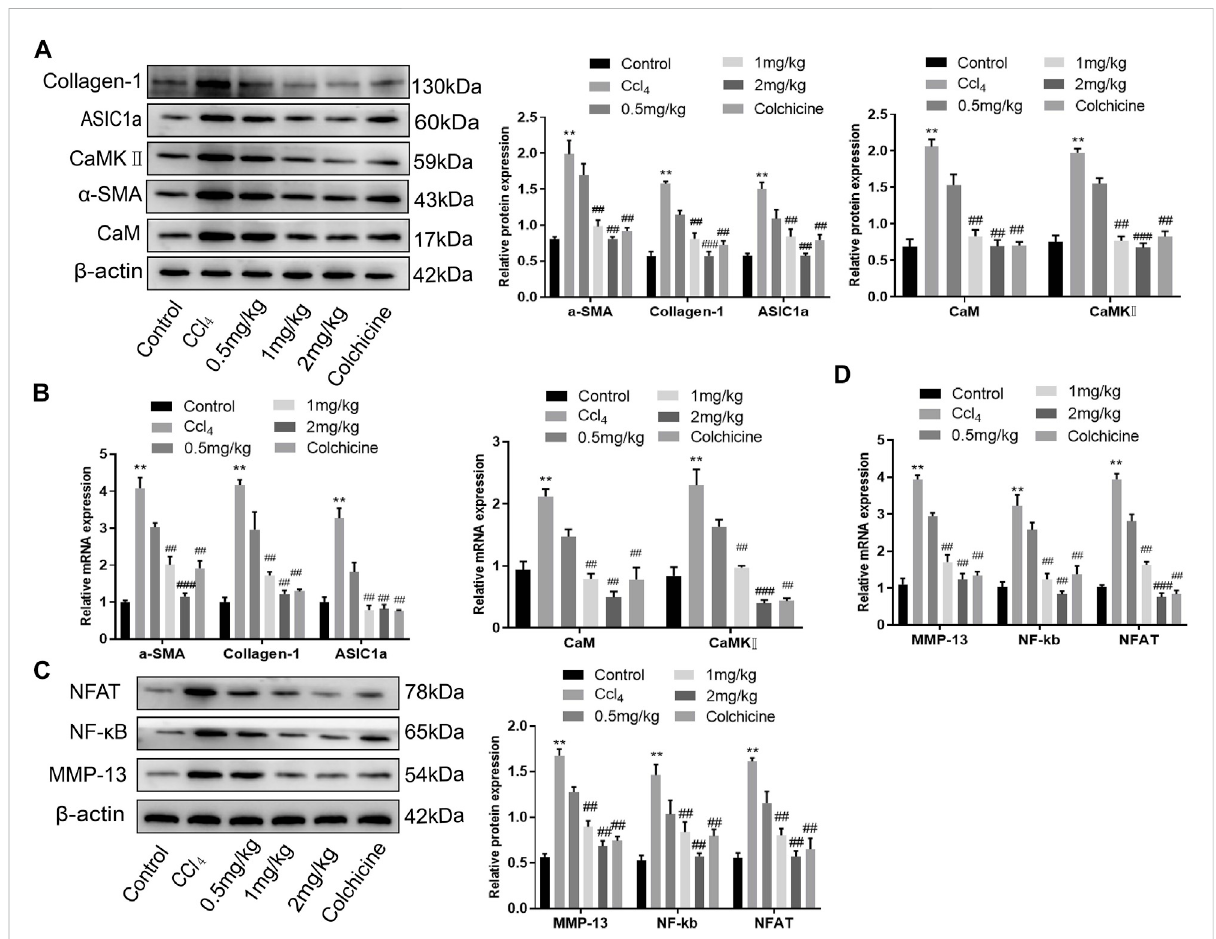
FIGURE 7 EffectsofKN93onproteinandmRNAexpressioninlivertissueofSDrats. (A) Westernblottinganalysisanddensitometricquanti fi cationofCaM, CaMK Ⅱ , and fi brosis proteins in HSCs of rats in each group. (B) mRNA levels of fi brosis protein, CaM and CaMK Ⅱ in HSCs of rats in each group. (C) Western blotting analysis and densitometric quanti fi cation of MMP-13, NF-kB and NFAT in HSCs of rats in each group. (D) mRNA levels of MMP-13, NF-kBandNFATinHSCsofratsineachgroup.Dataareexpressedasthemean±SD( n ≥ 3).* p < 0.05,** p < 0.01,*** p <